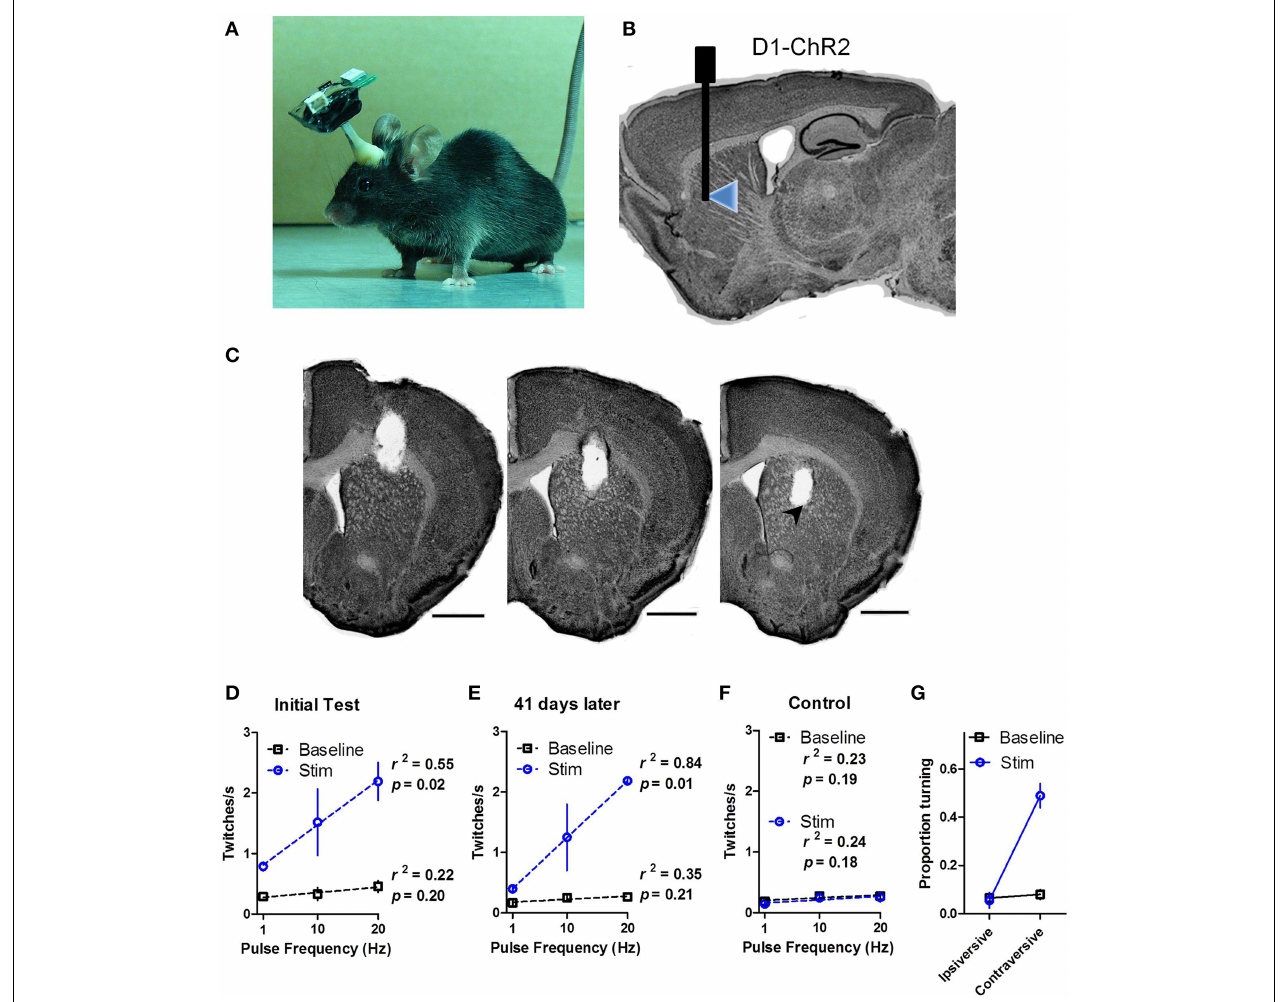
FIGURE 4 | In vivo wireless stimulation of striatonigral neurons drives behavior. (A) Photograph of a mouse with wireless headstage. (B) Schematic illustration of LED placement within the dorsal striatum of D1-ChR2 mice. (C) Representative serial coronal sections through the shank track. LED placement is indicated by arrowhead. Scale bars are 1mm. (D) High power (32mW) LED stimulation of striatonigral neurons induces